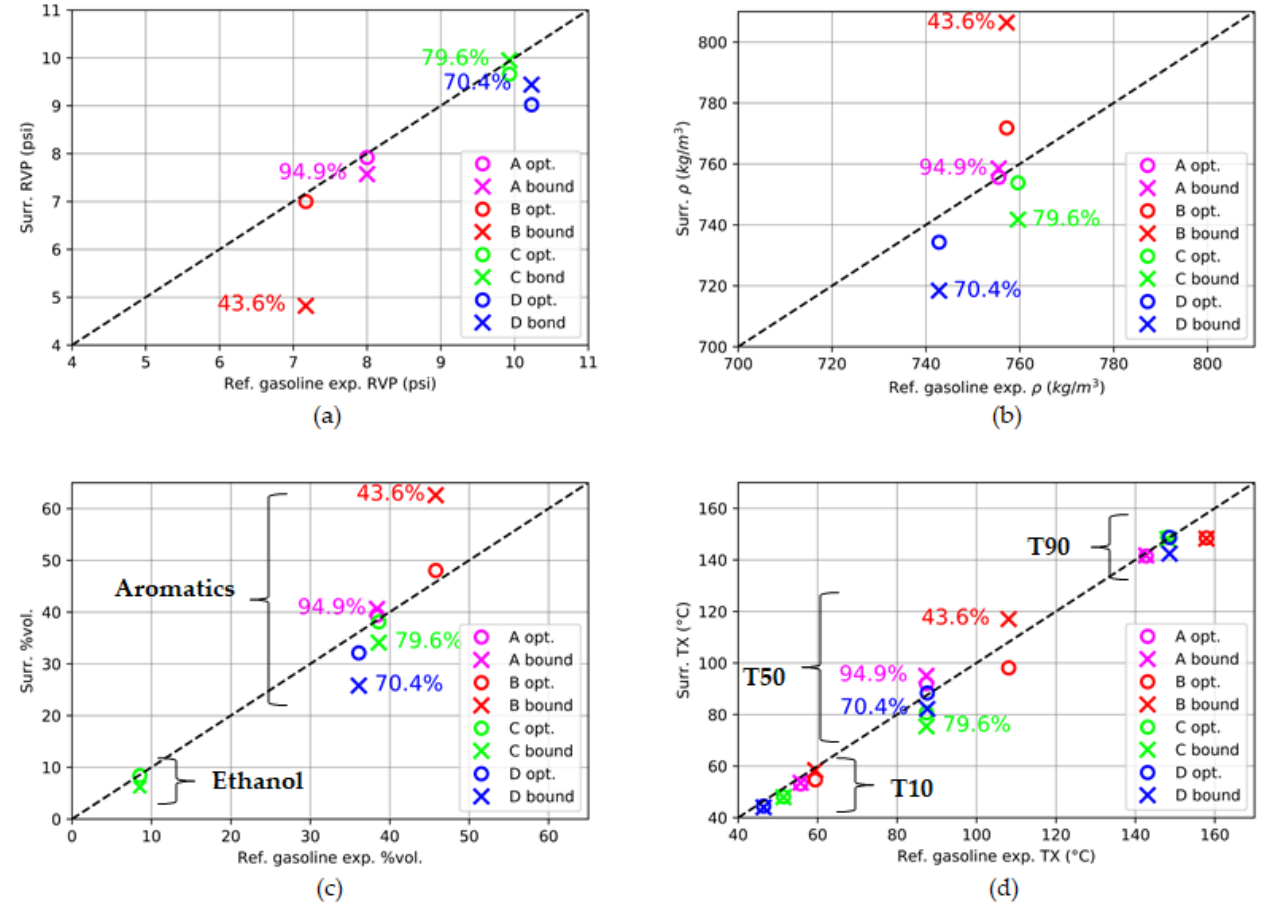
Figure 9. Parity plot of RVP ( a ), density ( b ), Ethanol and Aromatics composition ( c ), key distillation temperatures ( d ) for the optimum surrogate (circle) and the bound surrogate (cross) for the four validation gasolines A, B, C, D. Values of the overall compatibility between optimum and bound surrogates composition are also reported next to the markers.